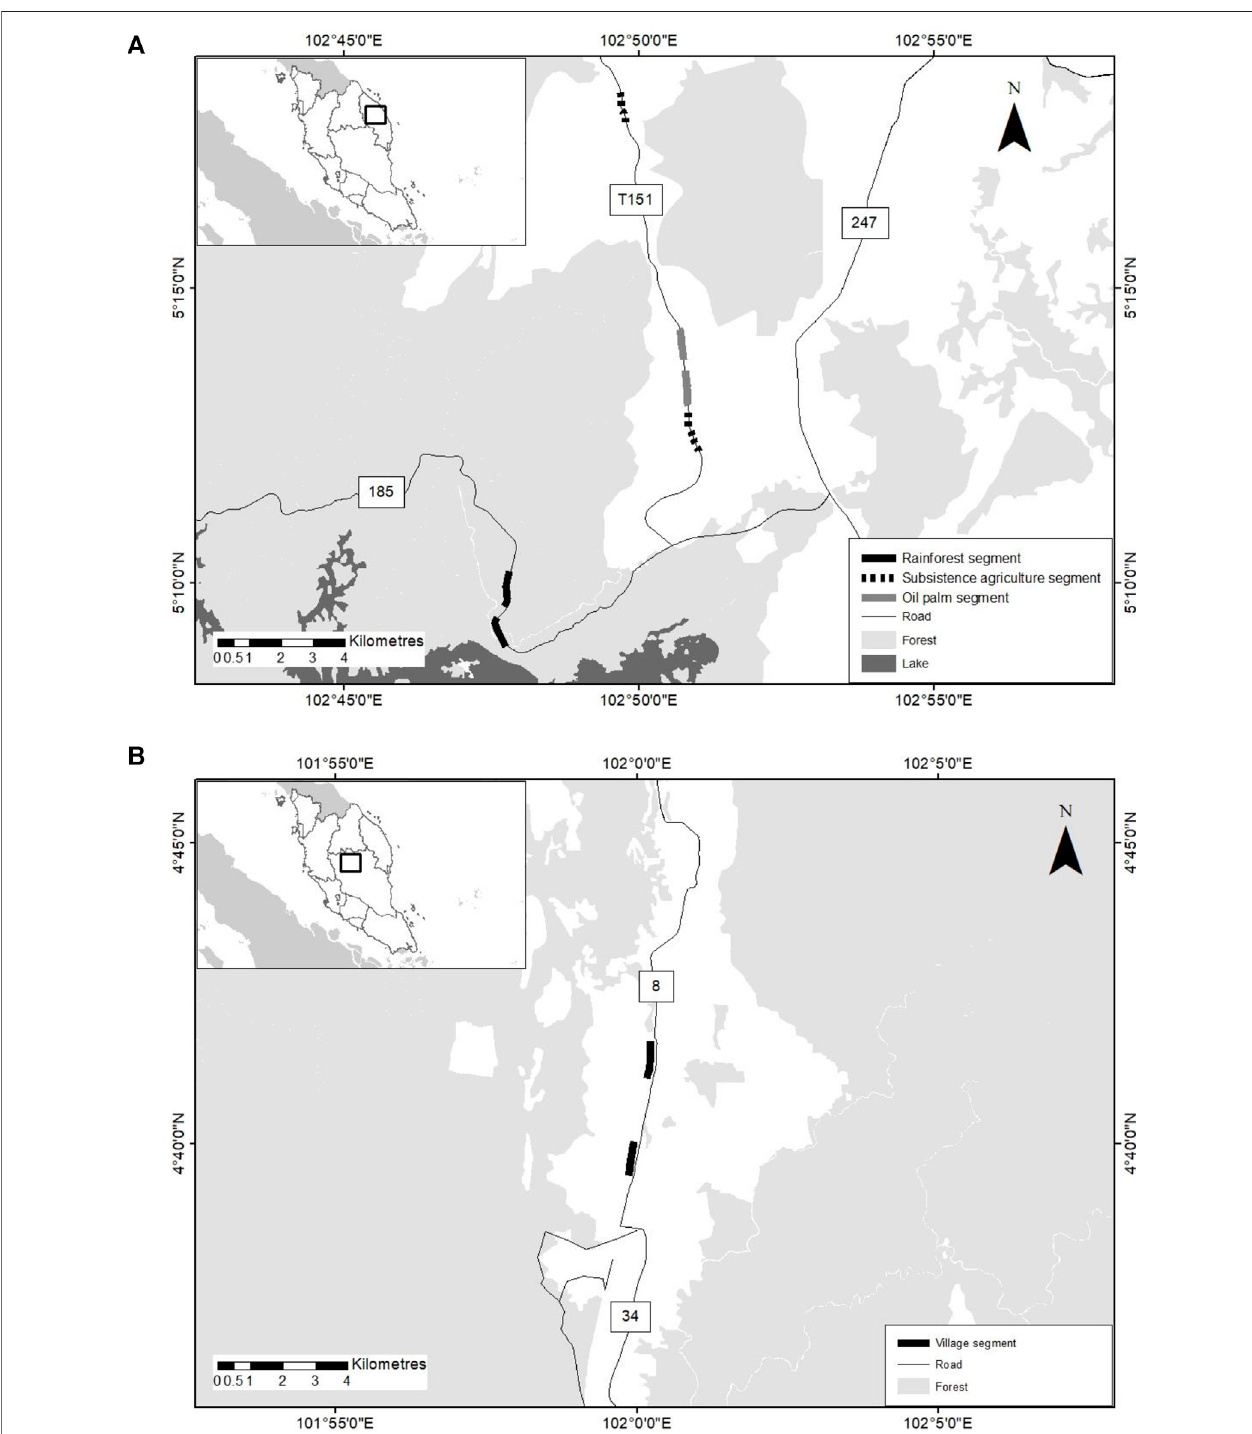
FIGURE 1 | Map of the surveyed road segments within Terengganu (A) and Pahang (B) , Peninsular Malaysia.